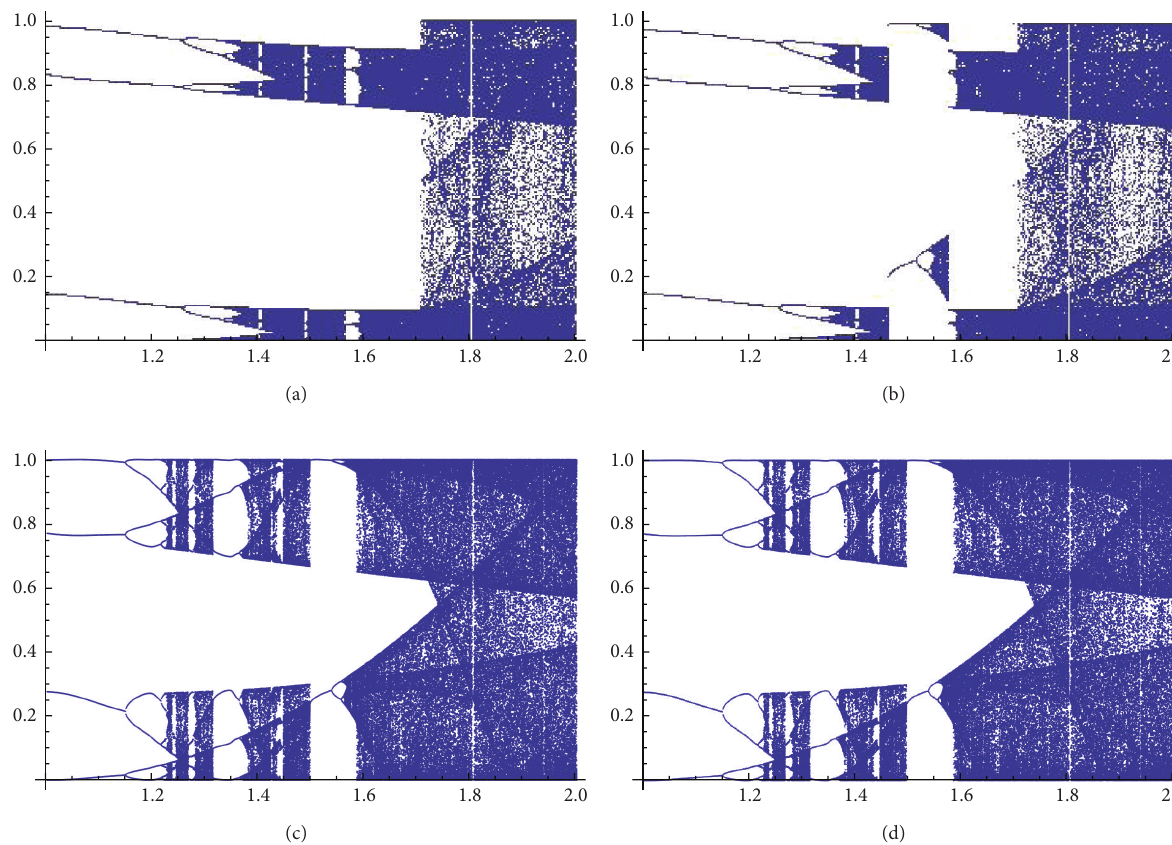
Figure 10: For 𝛼 = 1.3 , (a) and (b) show the bifurcation diagram for initial conditions 0 and 1 , respectively. The bifurcation diagrams are constructed with generating orbits of length 100200 and representing just the last 200 points. (c) and (d) show the same when 𝛼 = 1.35